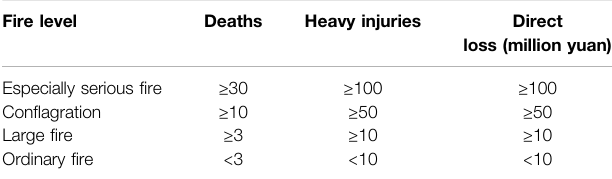
TABLE 2 | Standards for fi re level after 2007.